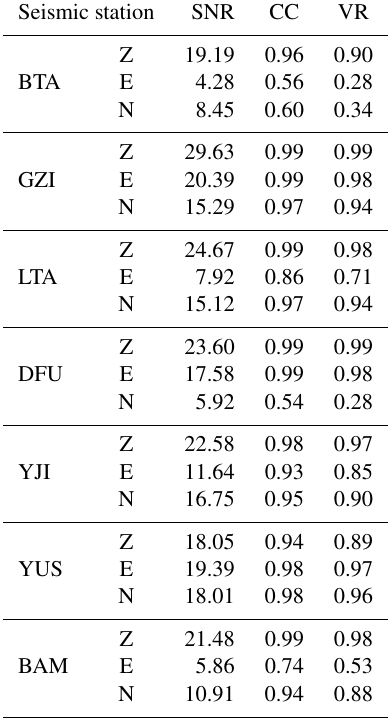
Table 3. SNR of seismic signals used in the inversion and CC and VR of the inversion